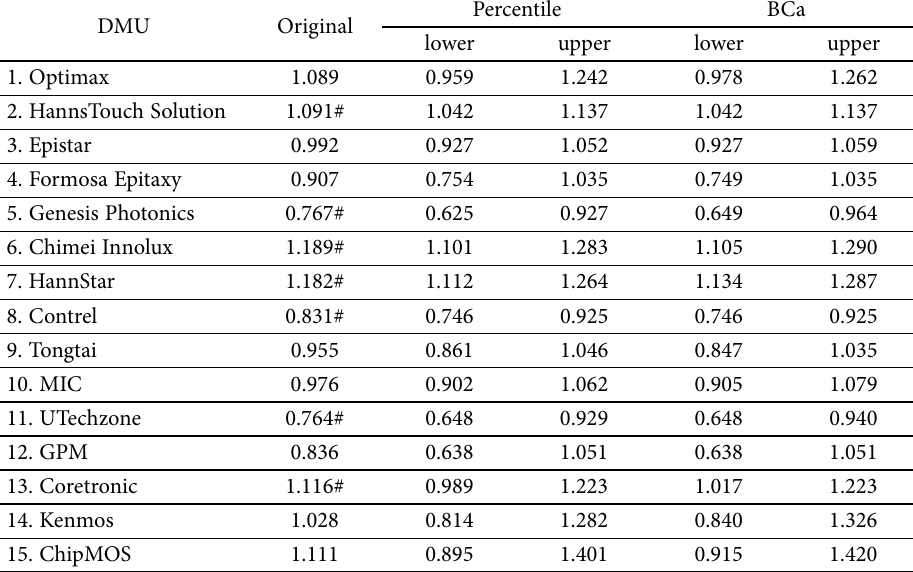
Table 12. Technical change with bootstrap Percentile BCa DMU Original lower upper lower